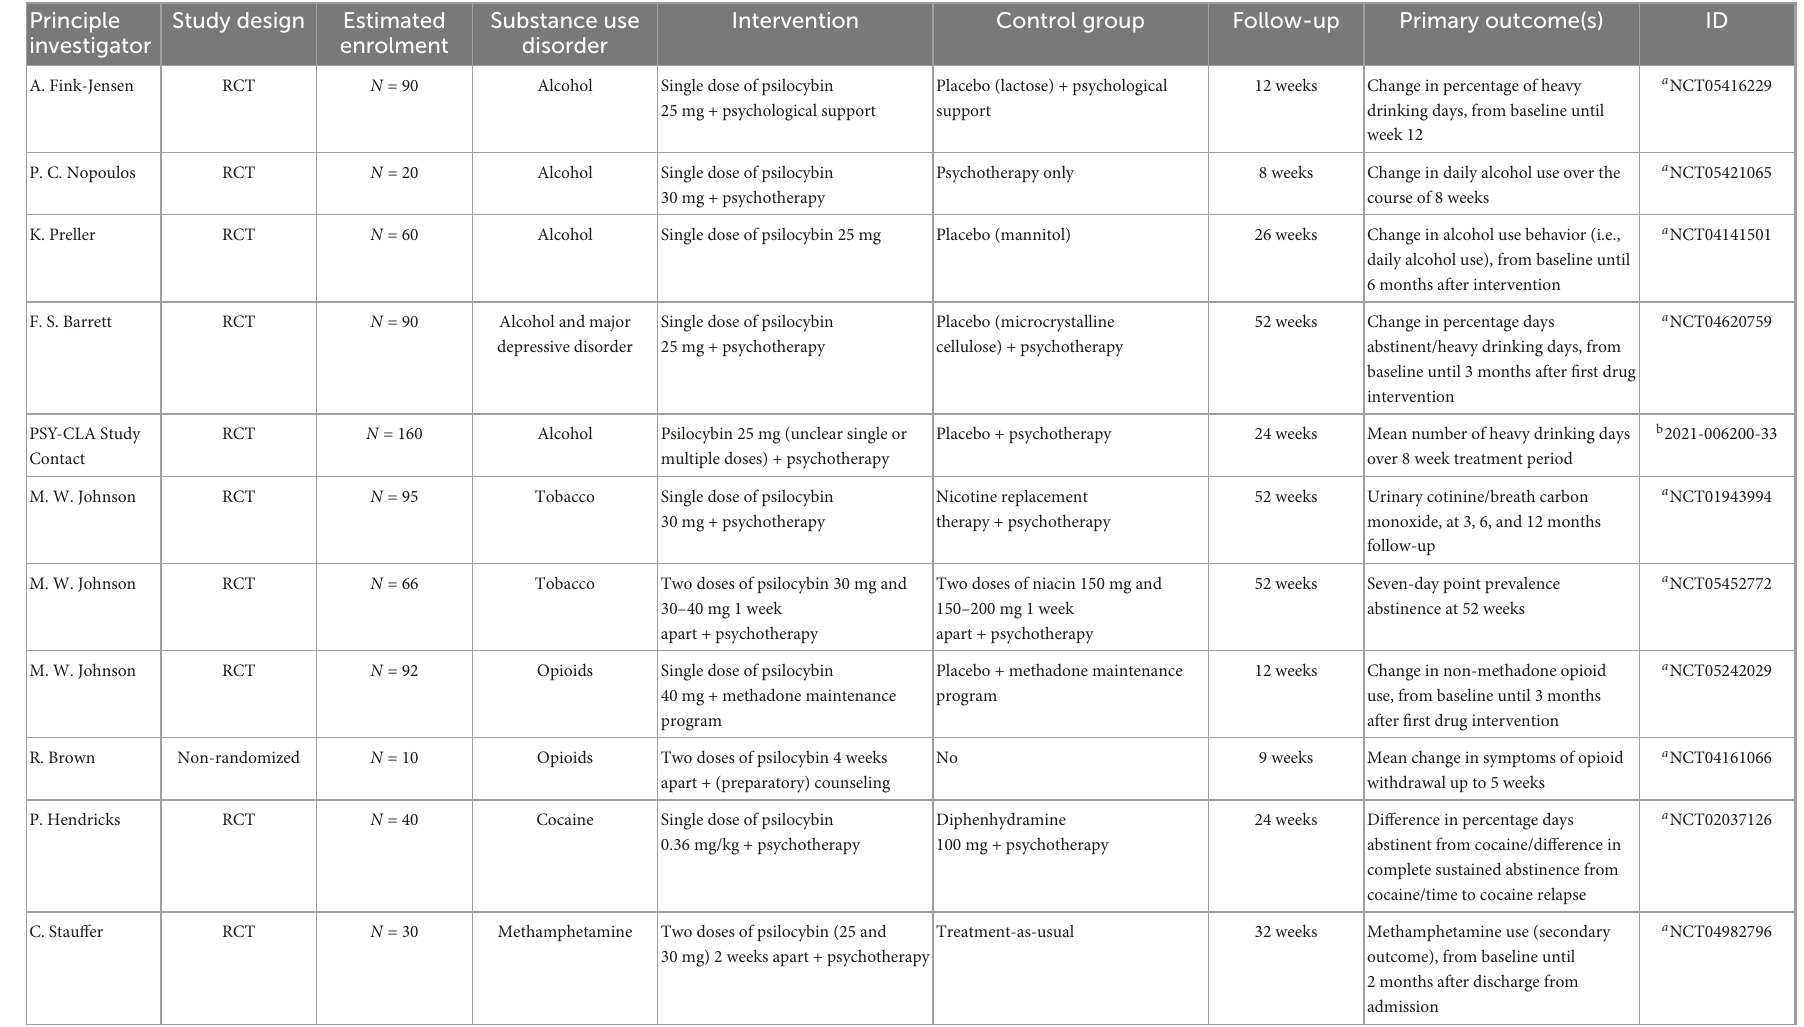
TABLE 2 Clinical trials being conducted on September 2, 2022 evaluating the efficacy of psilocybin in substance-use disorders. Principle Study investigator